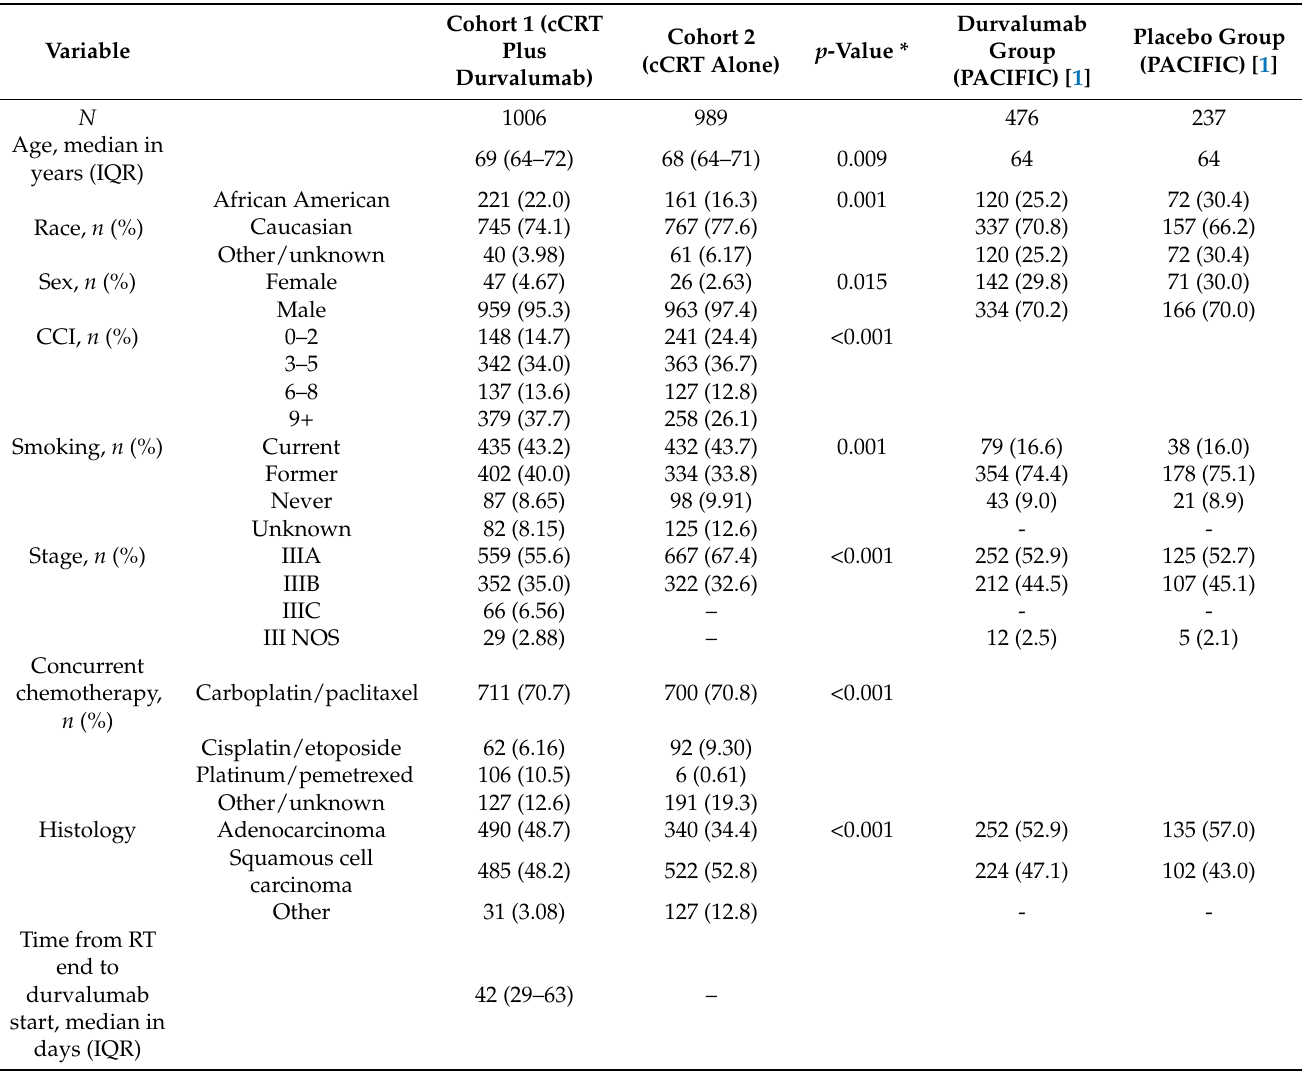
Table 1. Characteristics of patients who received cCRT plus durvalumab versus cCRT alone in the real-world setting and in the PACIFIC